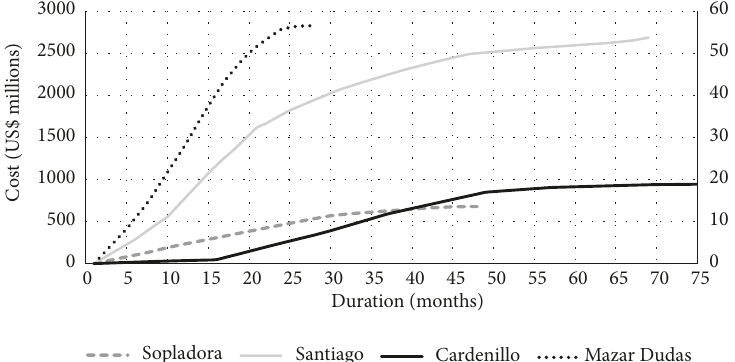
Figure 4: S-Curves that represent the baselines of the projects under analysis. The secondary scale represents the costs of the Mazar Dudas project only.